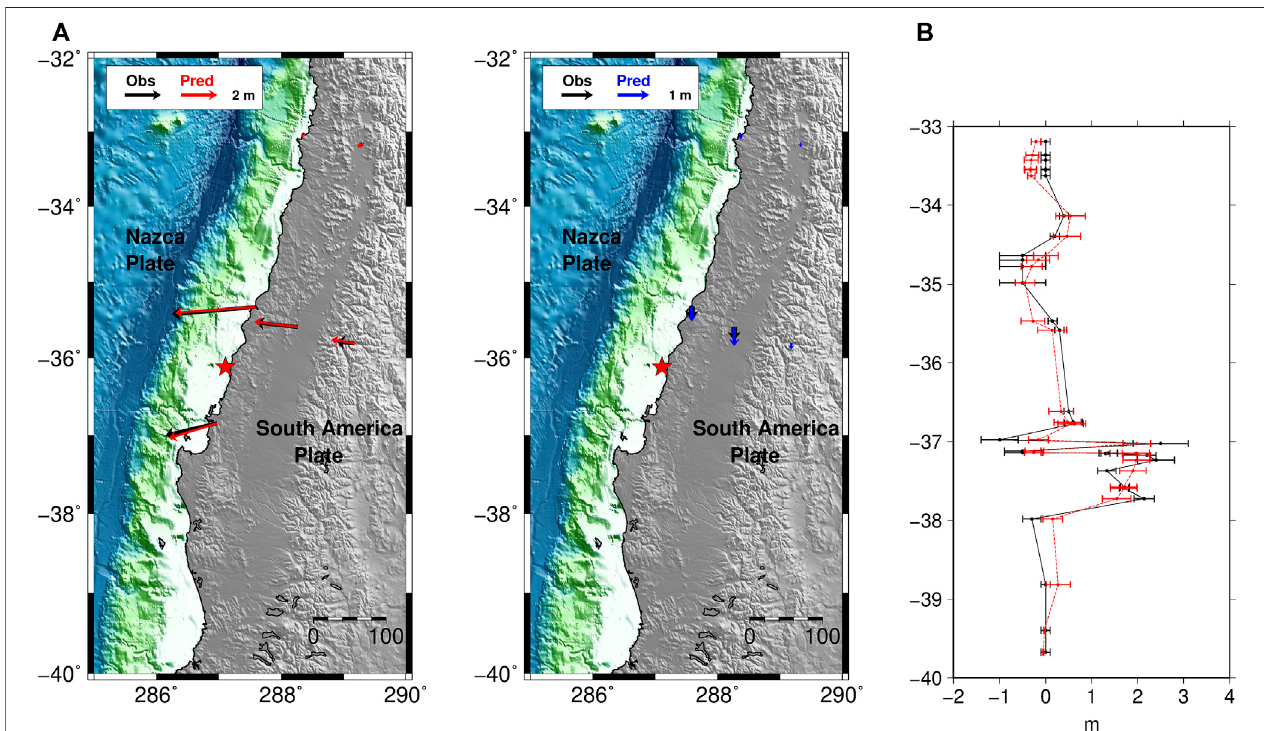
FIGURE9 | GPSand land-level data fi t for the slipmodel shown in Figure 6 .Comparison between observed (in black) and predicted (A) GPS data (horizontal and verticalinredand blue, respectively); (B) observed(black)and predicted (red)land-levelchanges;errorbarsforobservationsareexperimentaluncertainties,whereasfor predictions they are calculated adding ± 1 σ errors.